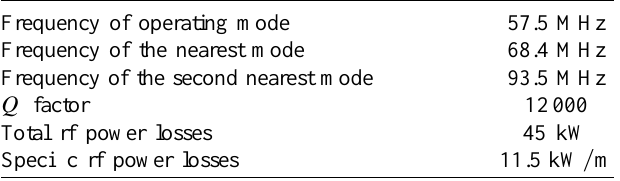
TABLE III. Calculated electrodynamic parameters of the cavity. Frequency of operating mode